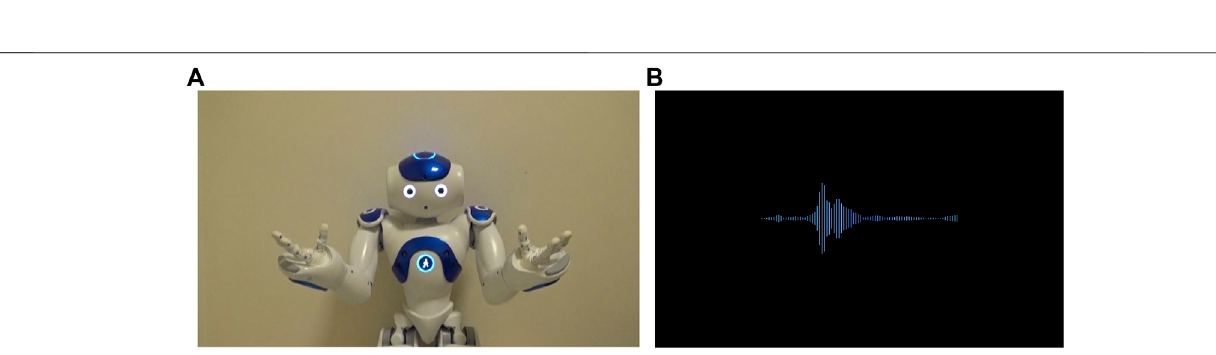
Frontiers in Robotics and AI |